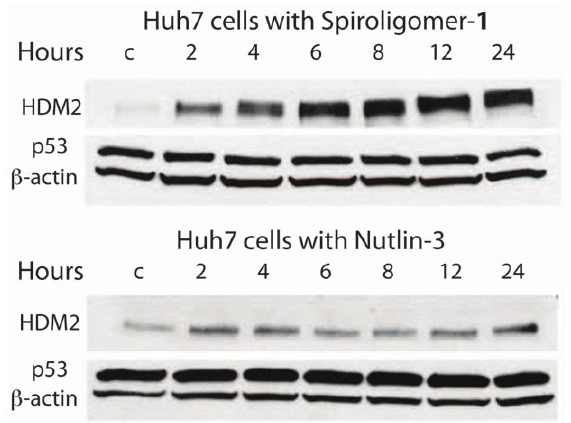
Figure 10. Time dependent Western analysis of the effect of compound 1 (15 m M) and nutlin-3 (15 m M) with Huh7 cells. Compound 1 causes a large increase in HDM2 levels with no effect on p53 Y220C levels. Nutlin-3 has very little effect on HDM2 and no observable effect on p53 Y220C levels.